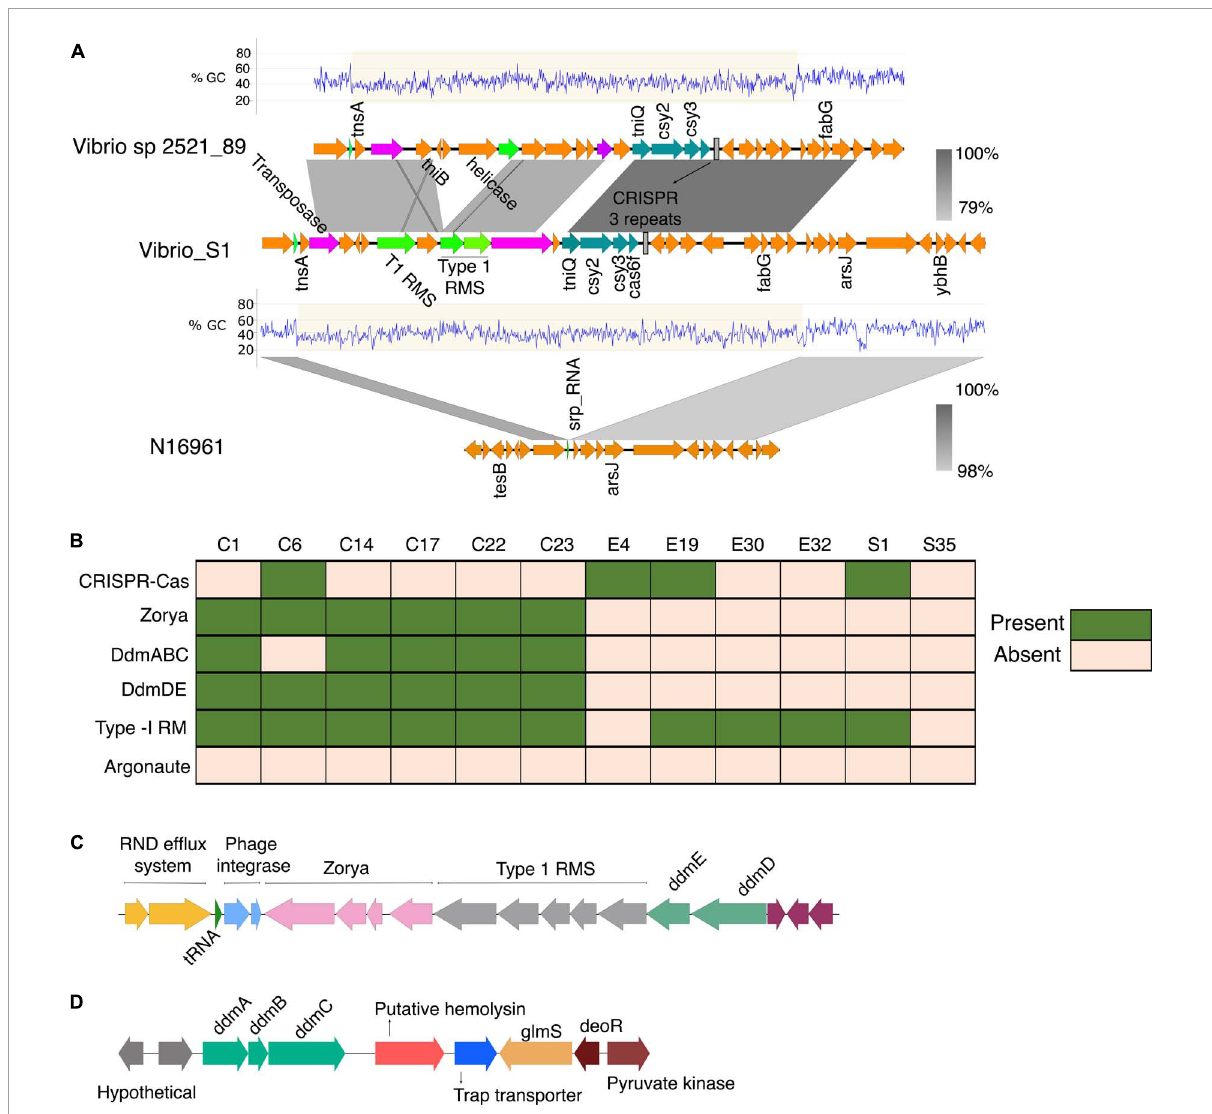
FIGURE6 (A) Genetic organization of the CRISPR-Cas system identified in the V. cholerae isolate S1. The Tn 7 - like transposon regions with the associated cargo carrying the mini type I-F CRISPR-Cas system in both V. cholerae isolate S1 and the Vibrio sp 2521_89 were aligned and compared using BLAST and EasyFig. The Tn 7 element is inserted into the site downstream of the signal recognition particle RNA (srp_RNA). (B) The distribution of phage defense mechanisms in the clinical and environmental vibrio isolates. (C) Schematic of the gene cluster containing the phage and plasmid defense components commonly found in VP_II. The gene order is representative of the clinical isolates from this study and the N16961. (D) Schematic of the ddmABC gene cluster in the V. cholerae clinical